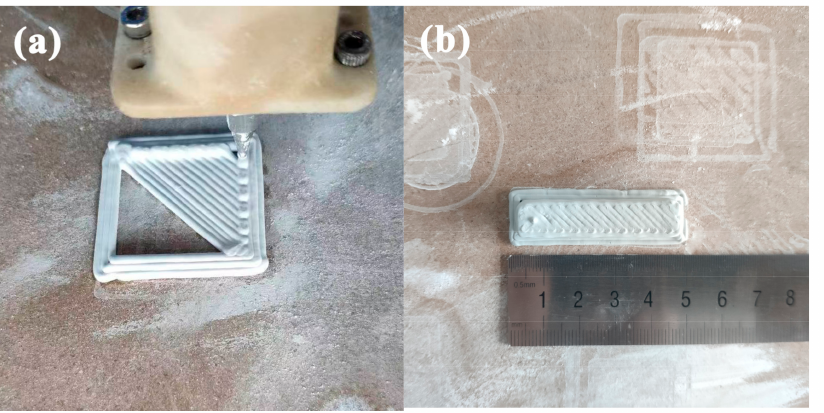
Figure 2. Extrusion printing of ceramic green bodies. ( a ) Ceramic green body being printed; ( b ) Printed ceramic green